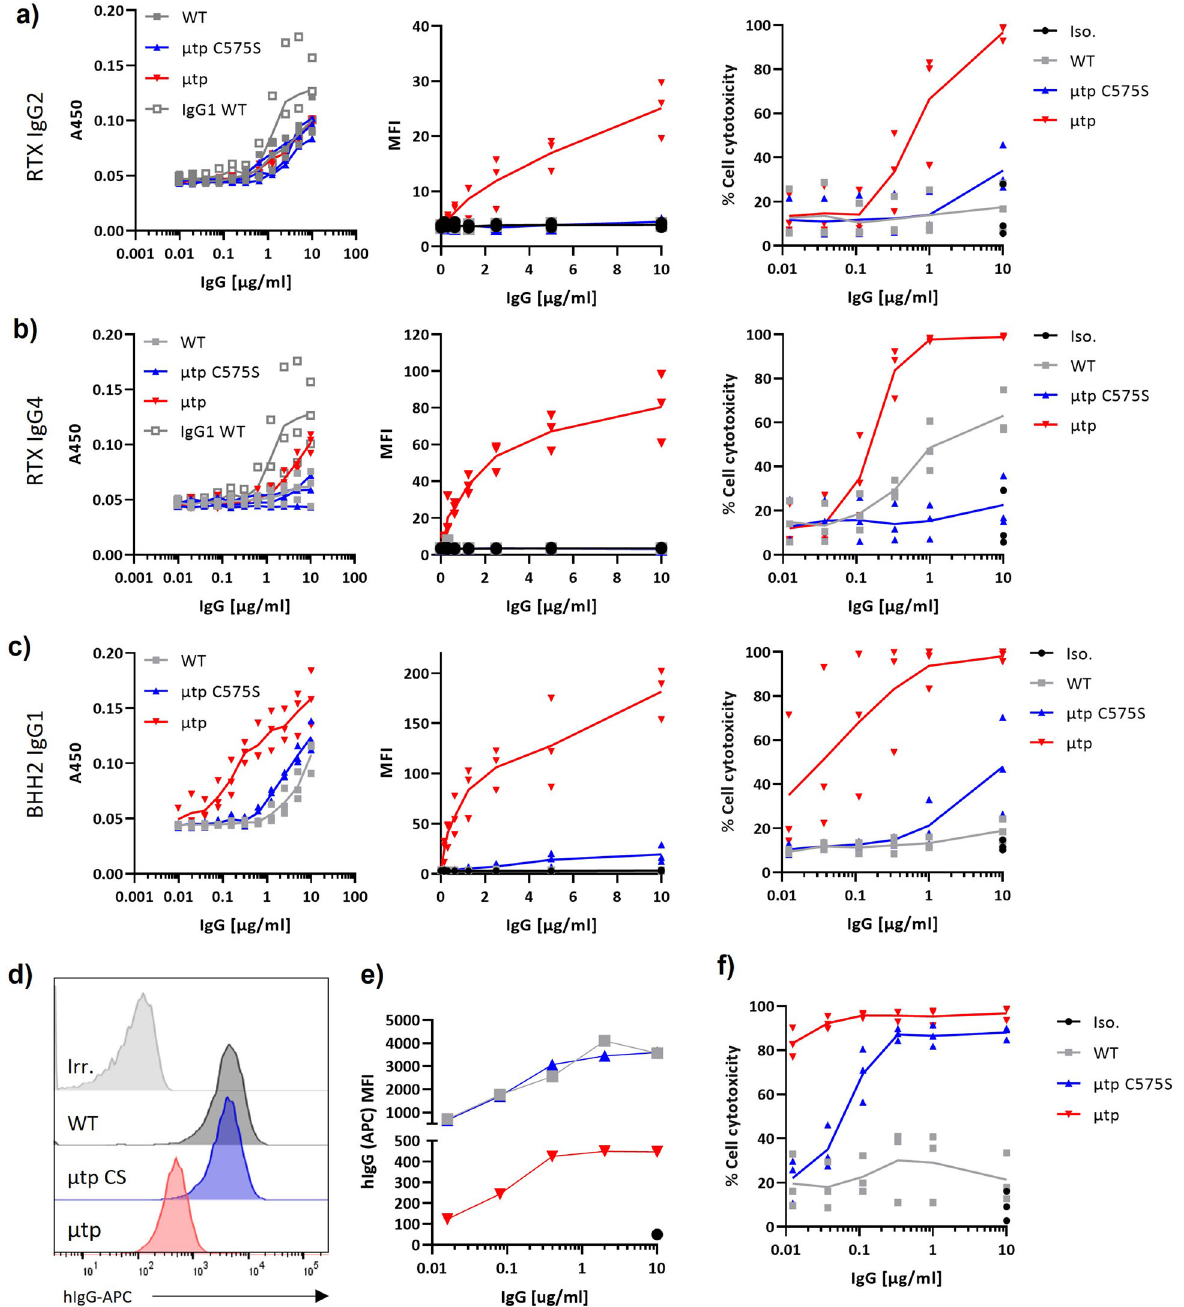
Fig. 4 CDC enhancement is also observed with different hIgG isotypes and another CD20 epitope. C1q binding was measured by ELISA. ELISA plates were coated with hIgG µ tp constructs at various concentrations and puri fi ed human C1q (2 μ g/ml) added. Bound C1q was detected with a goat-anti-C1q, followed by an anti-goat-HRP-conjugated antibody. Data show absorbance at 450 nm. C1q cell recruitment was assessed by opsonising Ramos cells with hIgG µ tp constructs, followed by incubation with 2 μ g/ml human C1q. Deposition of C1q was analysed with an anti-C1q-FITC antibody. CDC-induced cell death was assessed by opsonising Ramos cell with 10 – 0.15 µ g/ml hIgG µ tp constructs and incubated with NHS (20 % V/V). Cell death was examined as the percentage of PI-positive cells by fl ow cytometry. Results are shown for a rituximab hIgG2, b rituximab hIgG4, and c BHH2 hIgG1 µ tp constructs. d Ramos cells were opsonised with daratumumab (anti-CD38) hIgG1 μ tp mAb at 10 μ g/ml and binding measured by secondary anti-human Fc-APC- labelled antibody. Solid grey histograms indicate trastuzumab hIgG isotype control mAb. e Antibody binding (MFI) over a concentration range ( n = 1). f CDC-induced cell death was assessed for daratumumab μ tp antibodies after opsonisation of Ramos cells. Individual data points and mean shown from biologically independent experiments ( n =